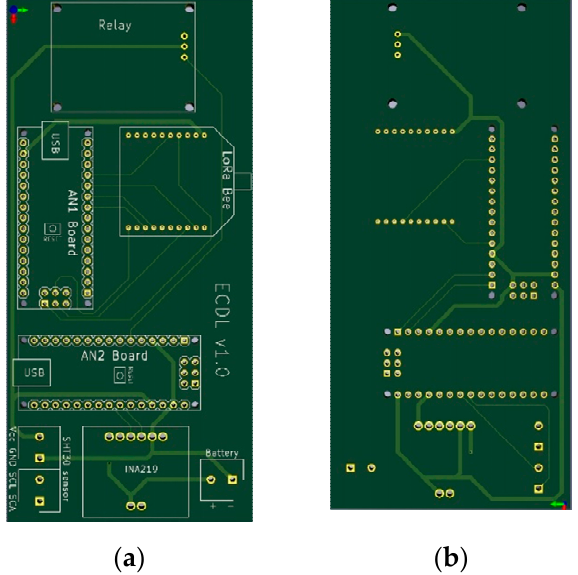
Figure 9. PCB of the ECDL with battery power supply: ( a ) front side and ( b ) back side.